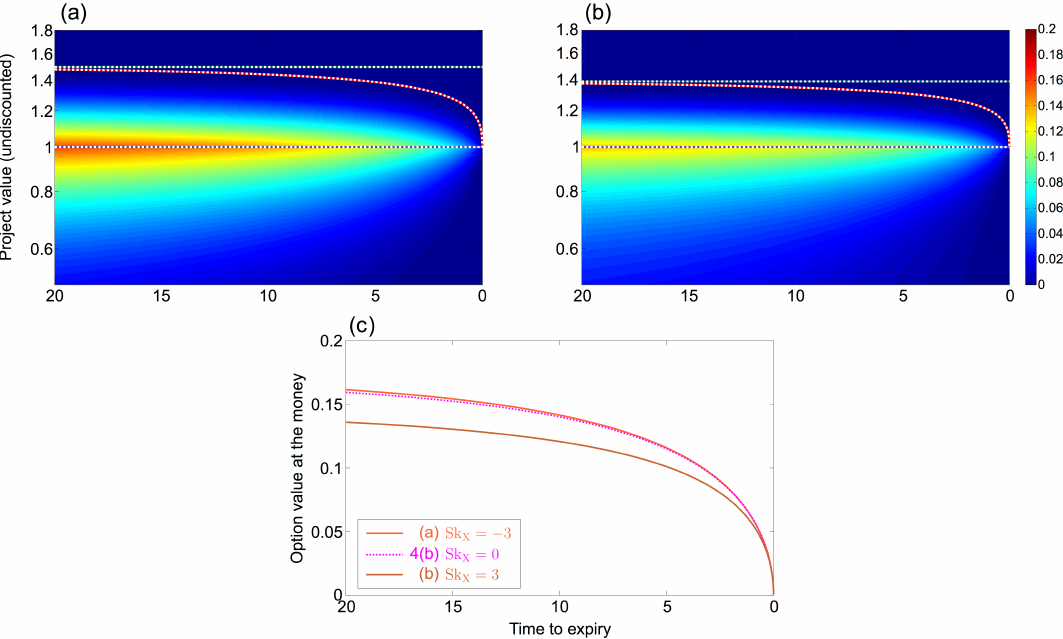
Figure 6. As in Figure 4b, but with skewness Sk X equal to: ( a ) − 3; ( b ) 3; ( c ) Plot of undiscounted option value at the money, versus time to expiry, for the three cases in Sk X = − 3,0,3. Exercise threshold at t = 0: ( a ) 1.4767; ( b ) 1.3762. Option value at the money ( t = 0): ( a ) 0.1614; ( b ) 0.1359. Calculation times (backwards induction step): ( a ) 4.12 s; ( b ) 5.04